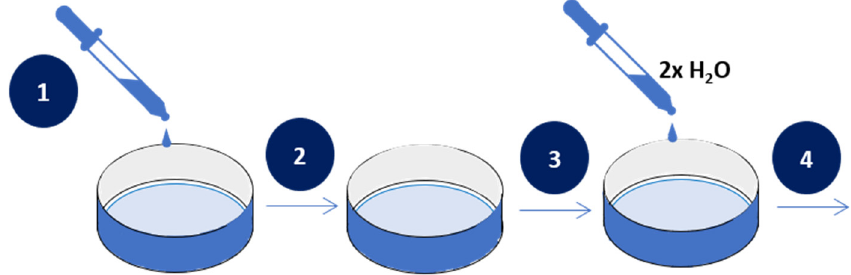
Figure 1. The procedure of membrane deposition. The membrane was poured onto the coverslips ( 1 ). Then, the membrane dries overnight at room temperature ( 2 ). The coverslips were washed twice with deionized water ( 3 ) and transferred to the culture wells ( 4 ).